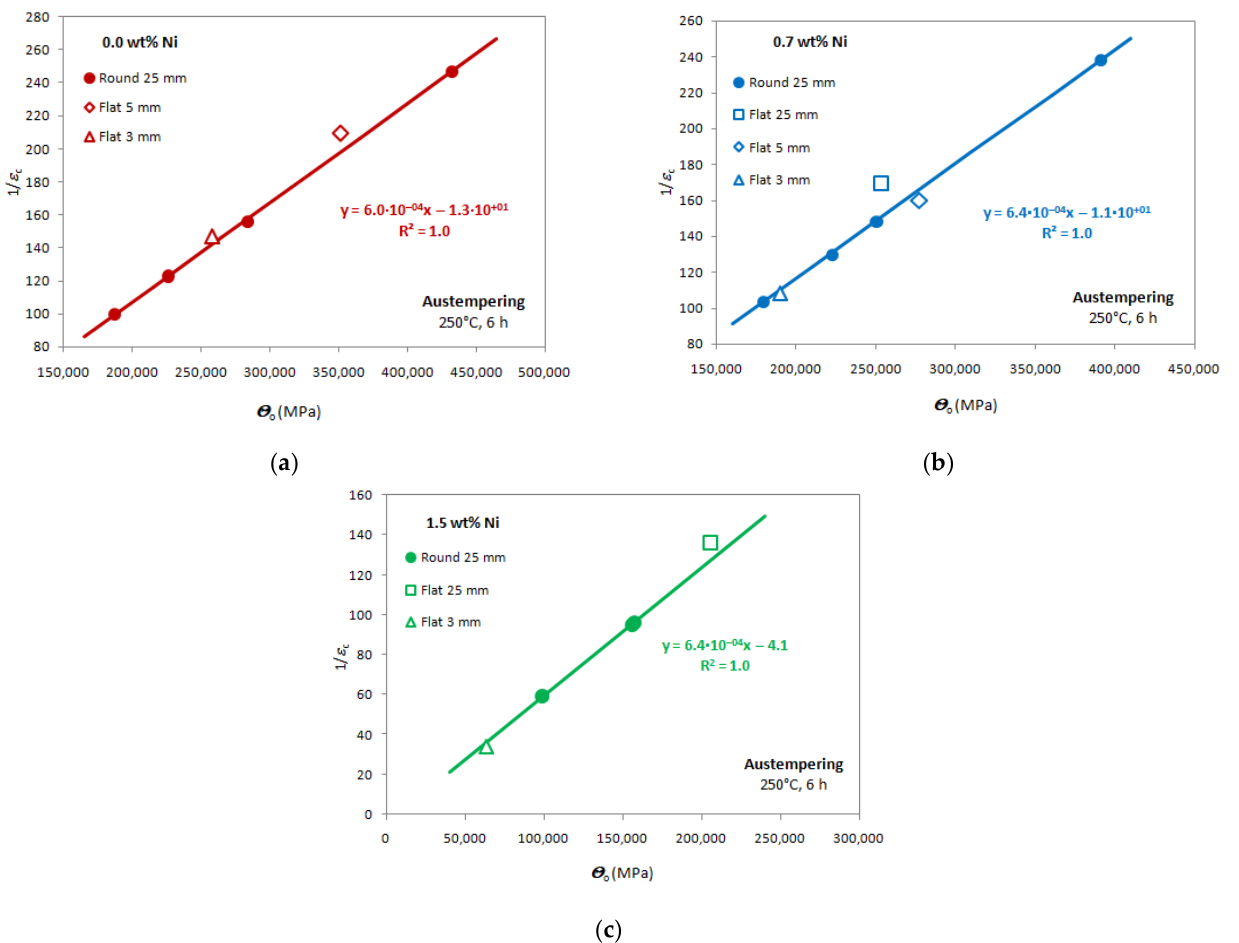
Figure 15. MADs for 25 mm Y-block ADIs (round tensile specimens and flat specimens), 5 mm and 3 mm thin castings with austempering conditions 250 °C and 6 h with different Ni content: ( a ) nominal 0.0 wt% Ni; ( b ) nominal 0.7 wt% Ni; ( c ) nominal 1.5 wt% Ni.